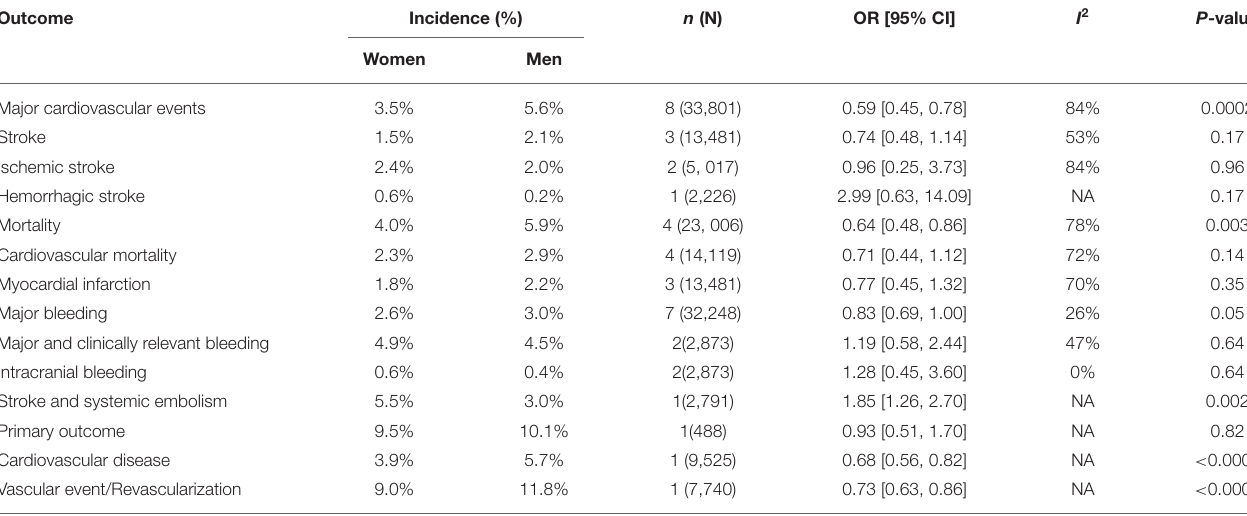
TABLE 3 | Role of aspirin in primary prevention of MACE, stroke, mortality, and bleeding in Women compared with Men. Outcome